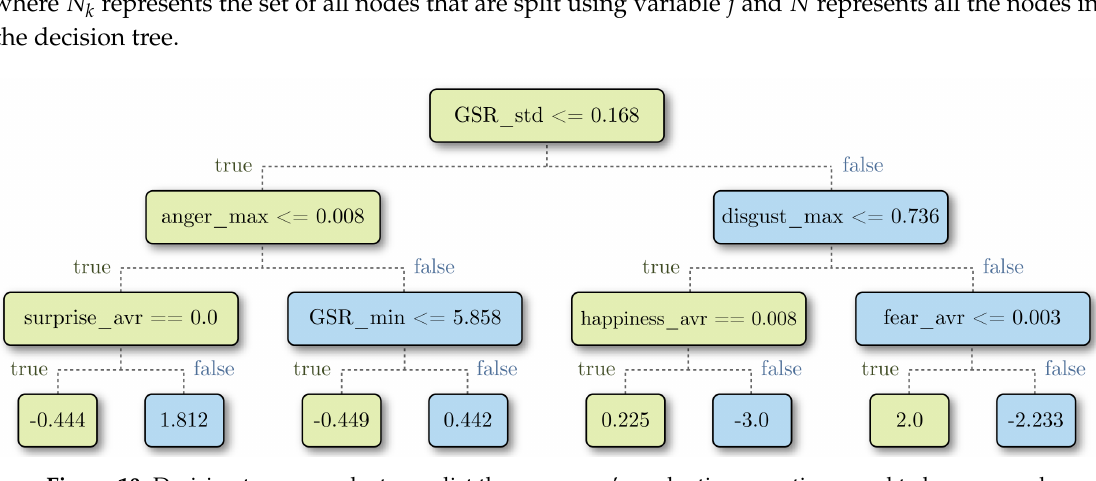
Figure 10. Decision tree example: to predict the consumer’s evaluation, questions need to be answered from top to bottom and following the path of the answers. At the end of the path, the last node contains the prediction of the consumer’s